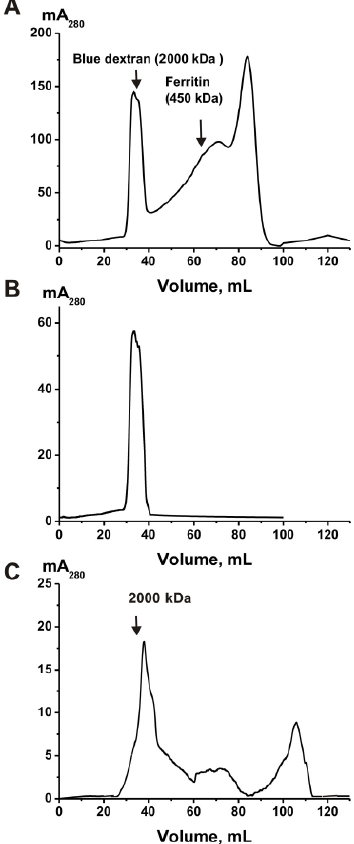
Figure 1. Isolation and analysis of sea cucumber complex. FPLC gel filtration of sea cucumber homogenate proteins on a Sepharose 4B column ( A ). Gel filtration of the purified complex ( A ) on the Sepharose 4B, MM = ≈ 2000 kDa ( B ). Gel filtration of the complex after its treatment using harsh conditions: 50 mM acidic buffer (pH 2.6), 8.0 M urea, 2 mM DTT, and 1.0 M NaCl ( C ). In all Panels, ( __ )—absorbance at 280 nm (A 280 ).